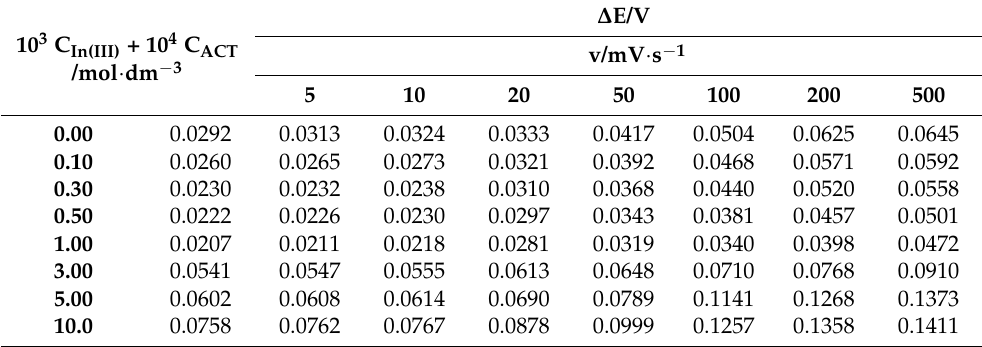
Table 1. Changes in ∆ E of the 1 × 10 − 3 mol · dm − 3 In(III) ions electroreduction process and in the presence of acetazolamide in 1 mol · dm − 3 of chlorates(VII) at the rate of polarization v. 10 3 C In(III) + 10 4 C